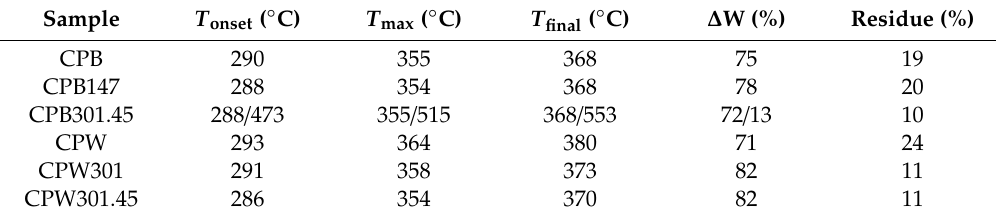
Figure 2. TGA curves, expressed as both the weight loss percentage and the associated derivative function, of ( top ) barley- and ( bottom ) wheat-straw-derived cellulose pulps. Table 2. Characteristic thermogravimetric analysis (TGA) parameters of the cellulose pulps studied.